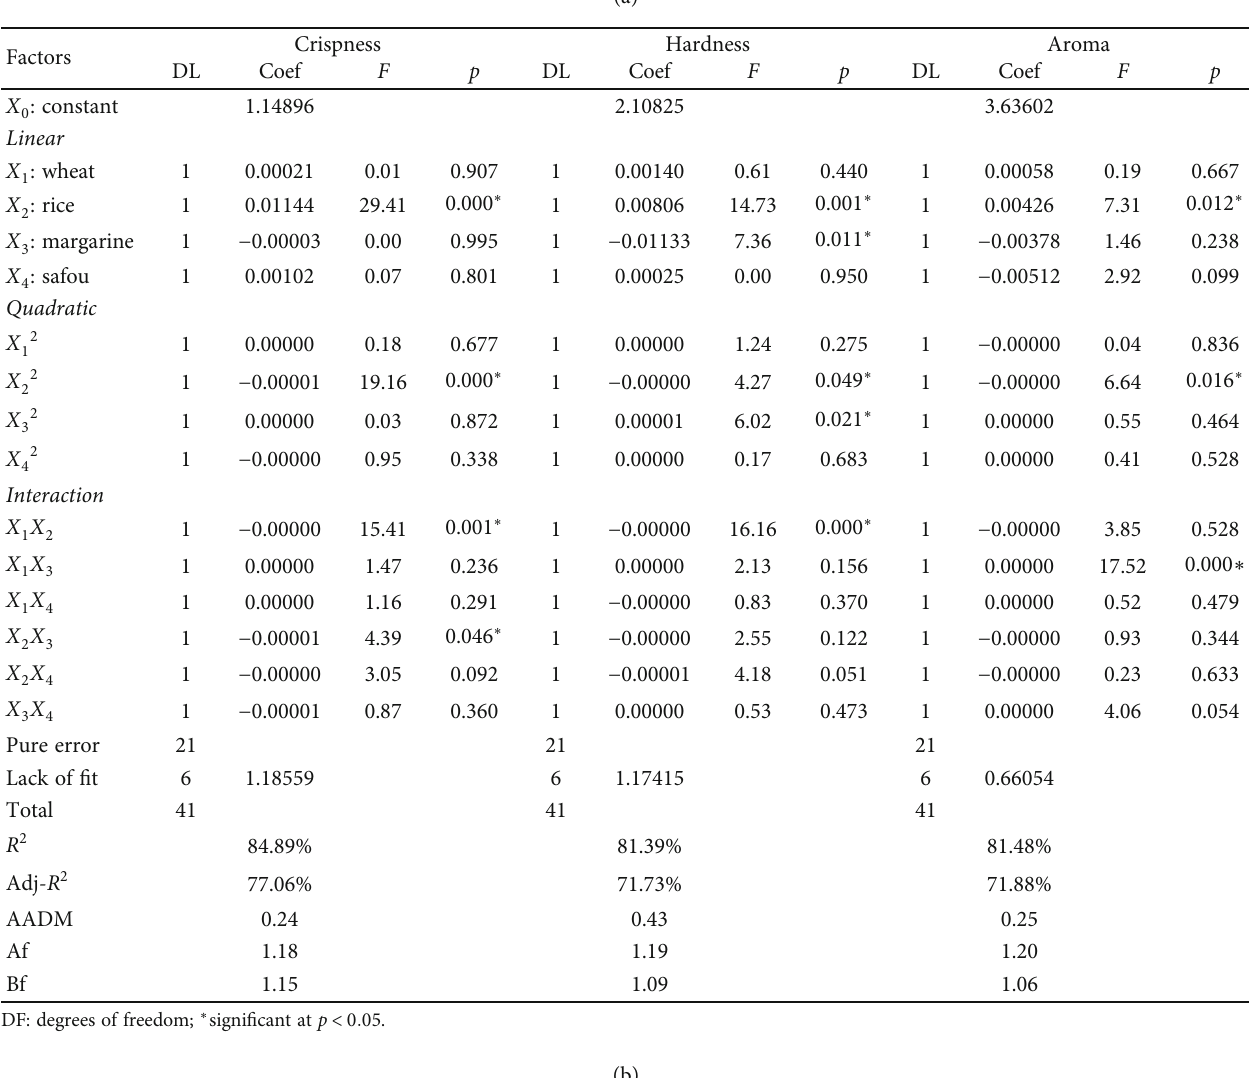
Table 3: ANOVA, regression coe ffi cients, and validation parameters of the second-order polynomial model for the di ff erent responses.